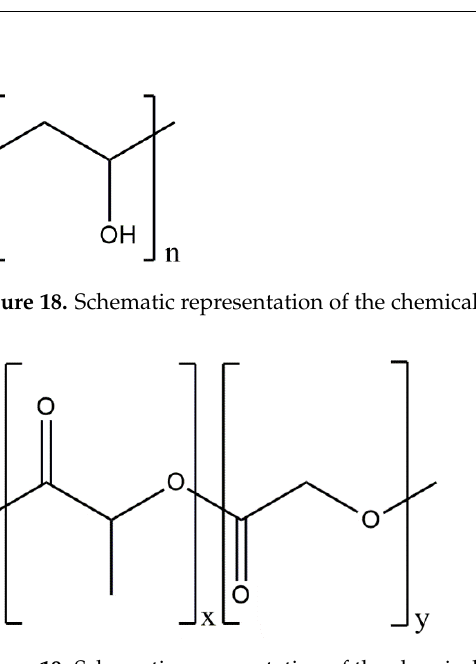
(TRC). Three types of